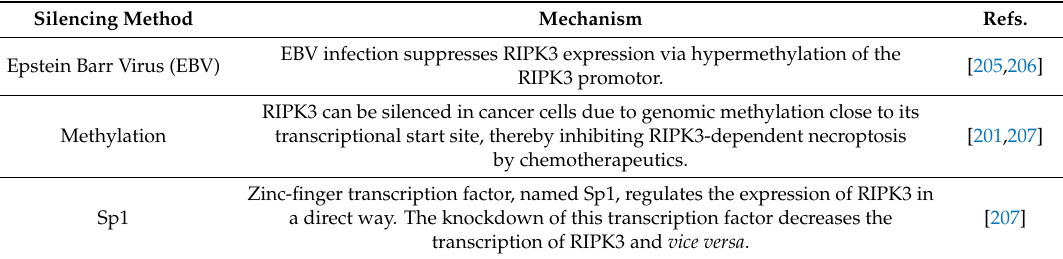
Table 2. RIPK3 epigenetic silencing methods employed by cancer